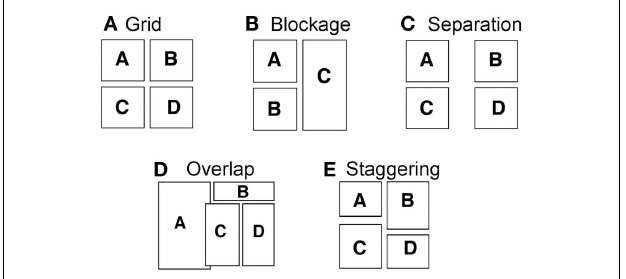
FIGURE 2 | Manipulations of comic page layouts. (A) Canonical grid layout stereotypically read in a “Z-path.” (B) Layout where a horizontal panel “blocks” the creation of a row of panels. (C) Layout where panels are separated by a wide space. (D) Layout where panels overlap each other. (E) Layout where panels are staggered to no longer retain a contiguous